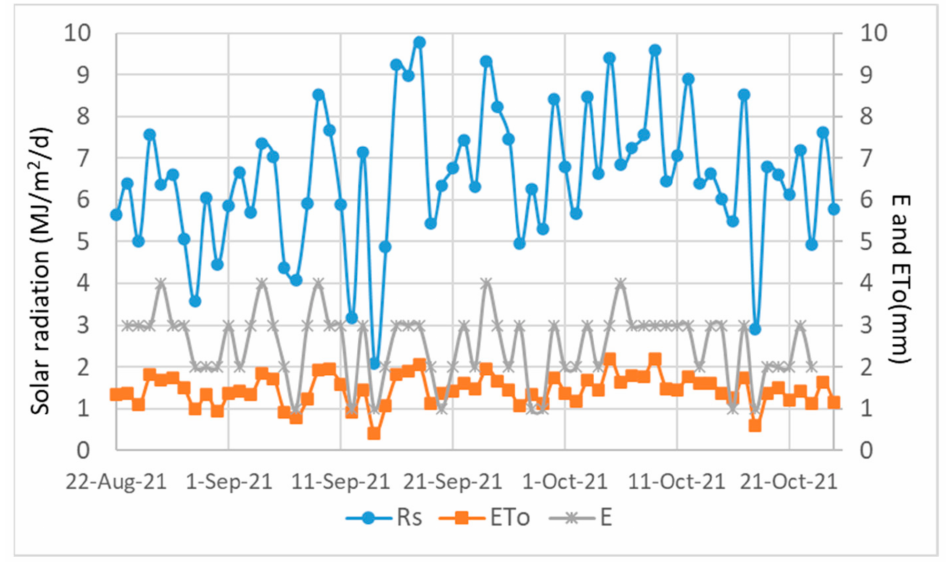
Figure 6. Daily total solar radiation, evaporation (E), and reference evapotranspiration